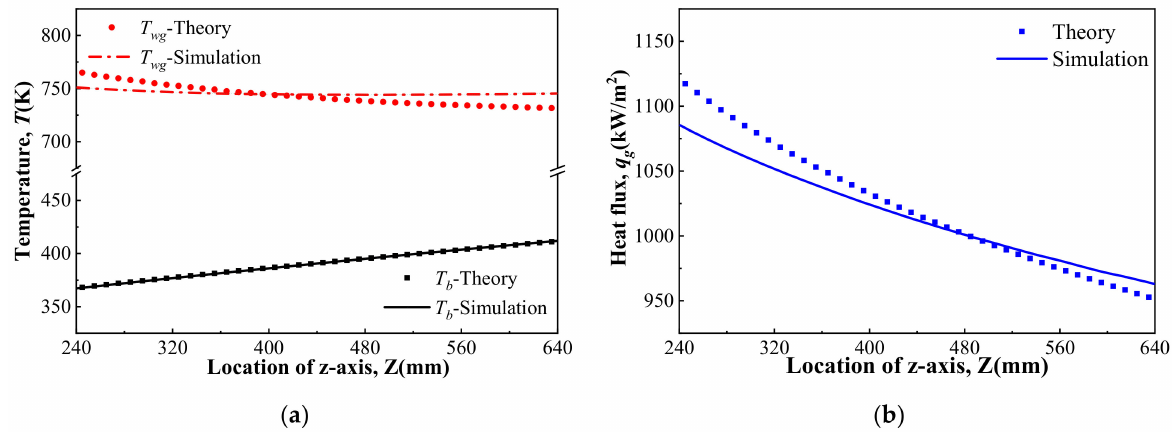
Figure 7. Comparison of T b , T wg and q g between simulation and theoretical calculations: ( a ) Variation of T b and T wg ( b ) Variation of q g